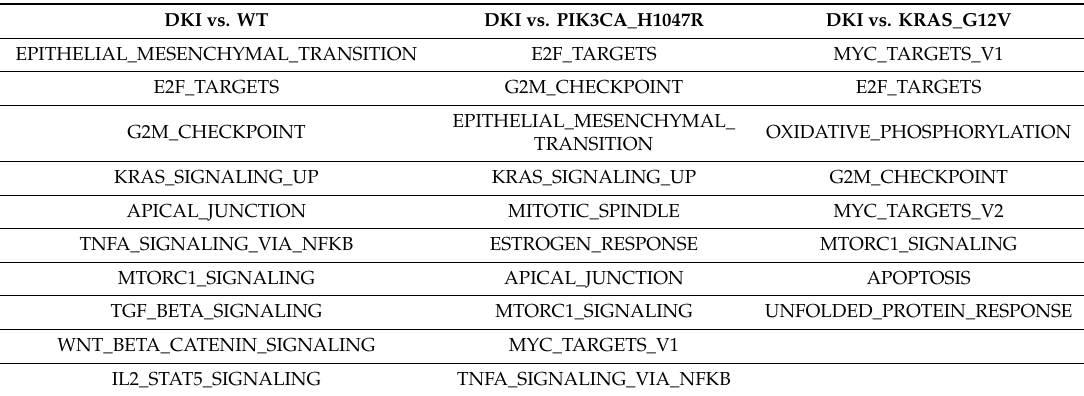
Table 2. Selected Hallmark Gene Signatures significantly upregulated in MCF-10A DKI vs. WT and single mutant cells as determined by